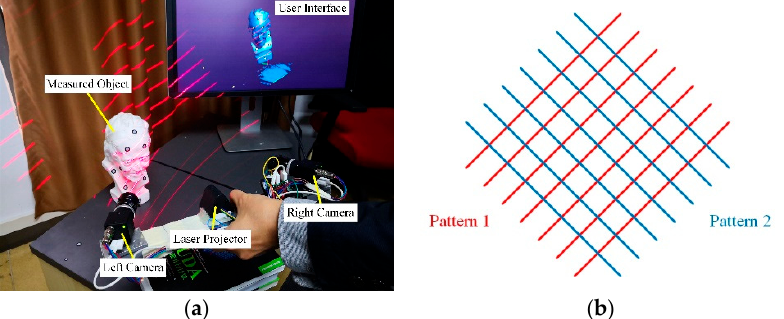
Figure 1. Schematic of the 3D laser scanning system; ( a ) components of the 3D scanner; ( b ) laser patterns; there are two kinds of projection patterns shown as red and blue respectively; we alternately project them onto the measured object; once one of the patterns is extracted, it will switch to the other immediately; the reflection of these two patterns will form multiple intersecting curves on the object.